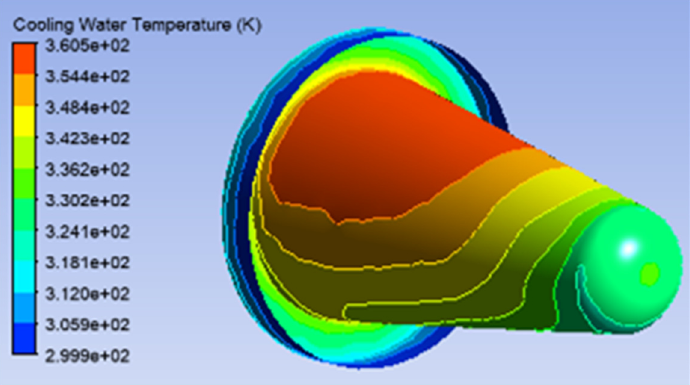
Figure 8. Temperature of the surface of the cooling water in contact with the niobium insert.